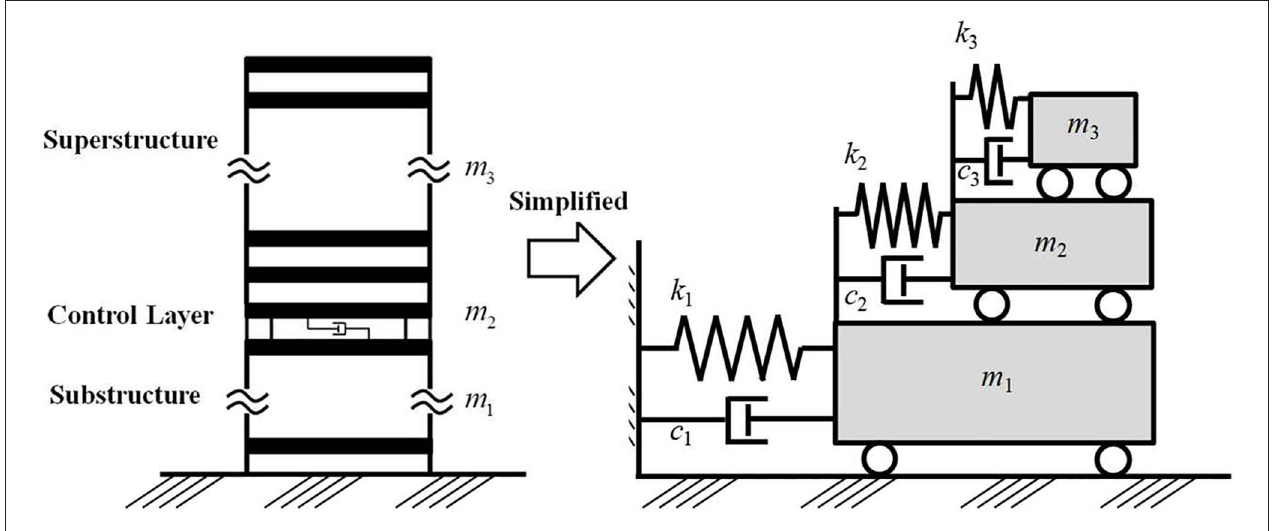
FIGURE 1 | Simplified 3DOF structure model of a BMD